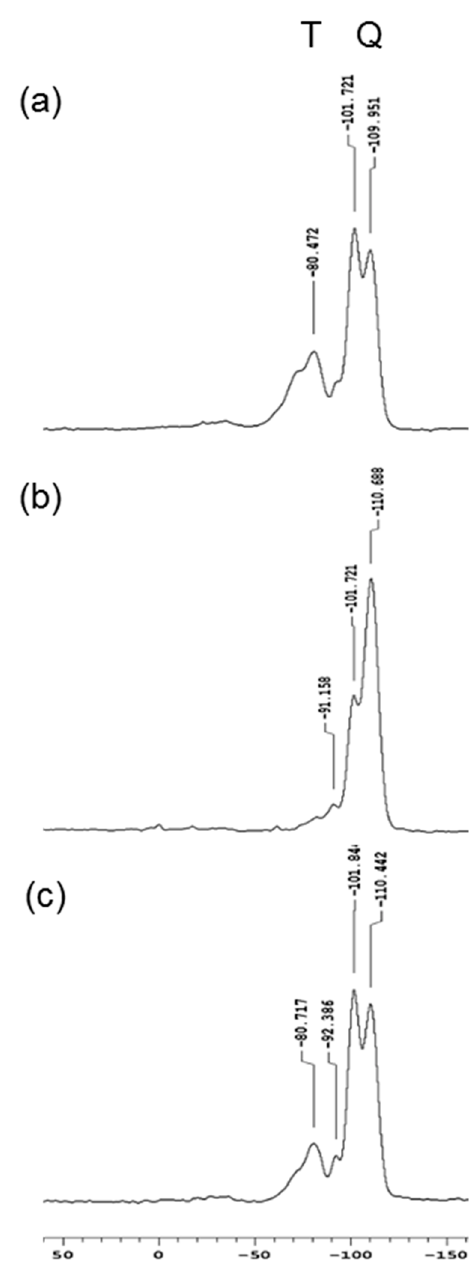
Figure 2. 29 Si CP/MAS NMR spectra of NPS xerogels. ( a ) NPSH, ( b ) NPSOH, ( c ) NPSN. Figure 2. 29 Si CP / MAS NMR spectra of NPS xerogels. ( a ) NPSH, ( b ) NPSOH, ( c )